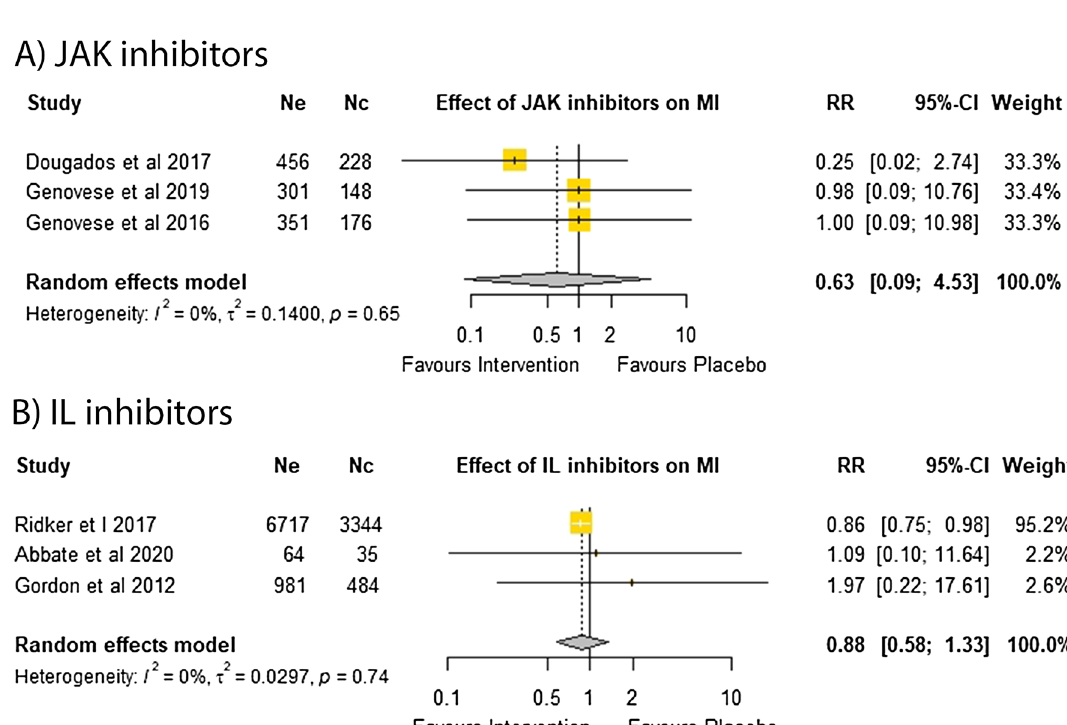
Figure 3. Effect of DMARDs on myocardial infarction